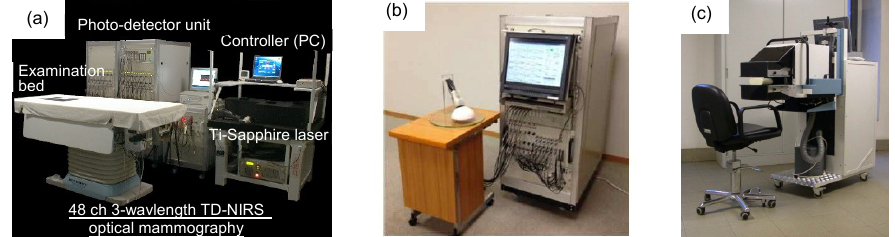
Figure 11. Photos of ( a ) the 48-channel TD-DOT for optical mammography [52]; ( b ) the 12-channel TD-NIRS system for optical mammography with a hand-held probe [53], and ( c ) the transmittance TD-NIRS imaging system for optical mammography with breast compression [54]. ( b ) Reproduced from Reference [53]. ( c ) Reproduced from Reference